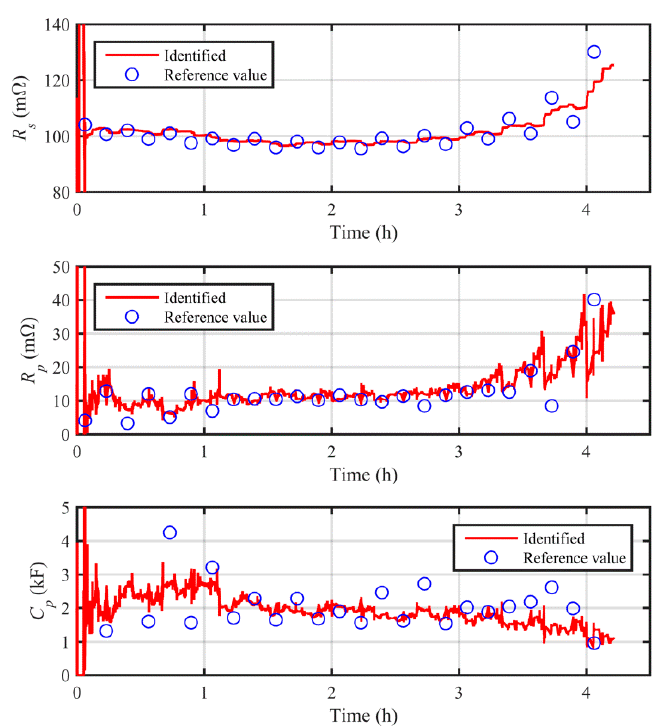
Figure 3. Results of model parameter identification with the proposed method.